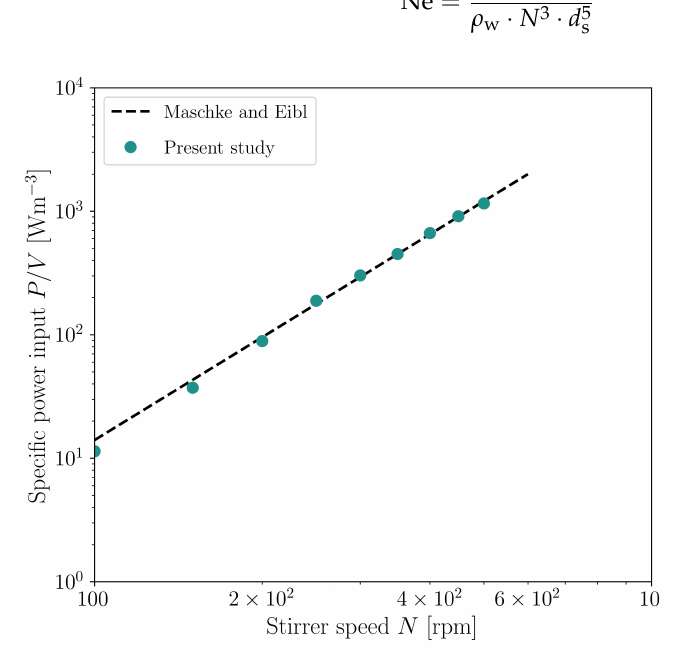
Figure 8. Calculated specific power input for the Minifors 2 with a 4L working volume. For comparison, the calculations of Maschke and Eibl [127] were used, which describe the specific power input as a function of the tip speed v tip for a working volume of 4L ( P / V = 131.79 · v 2.7670 d s =